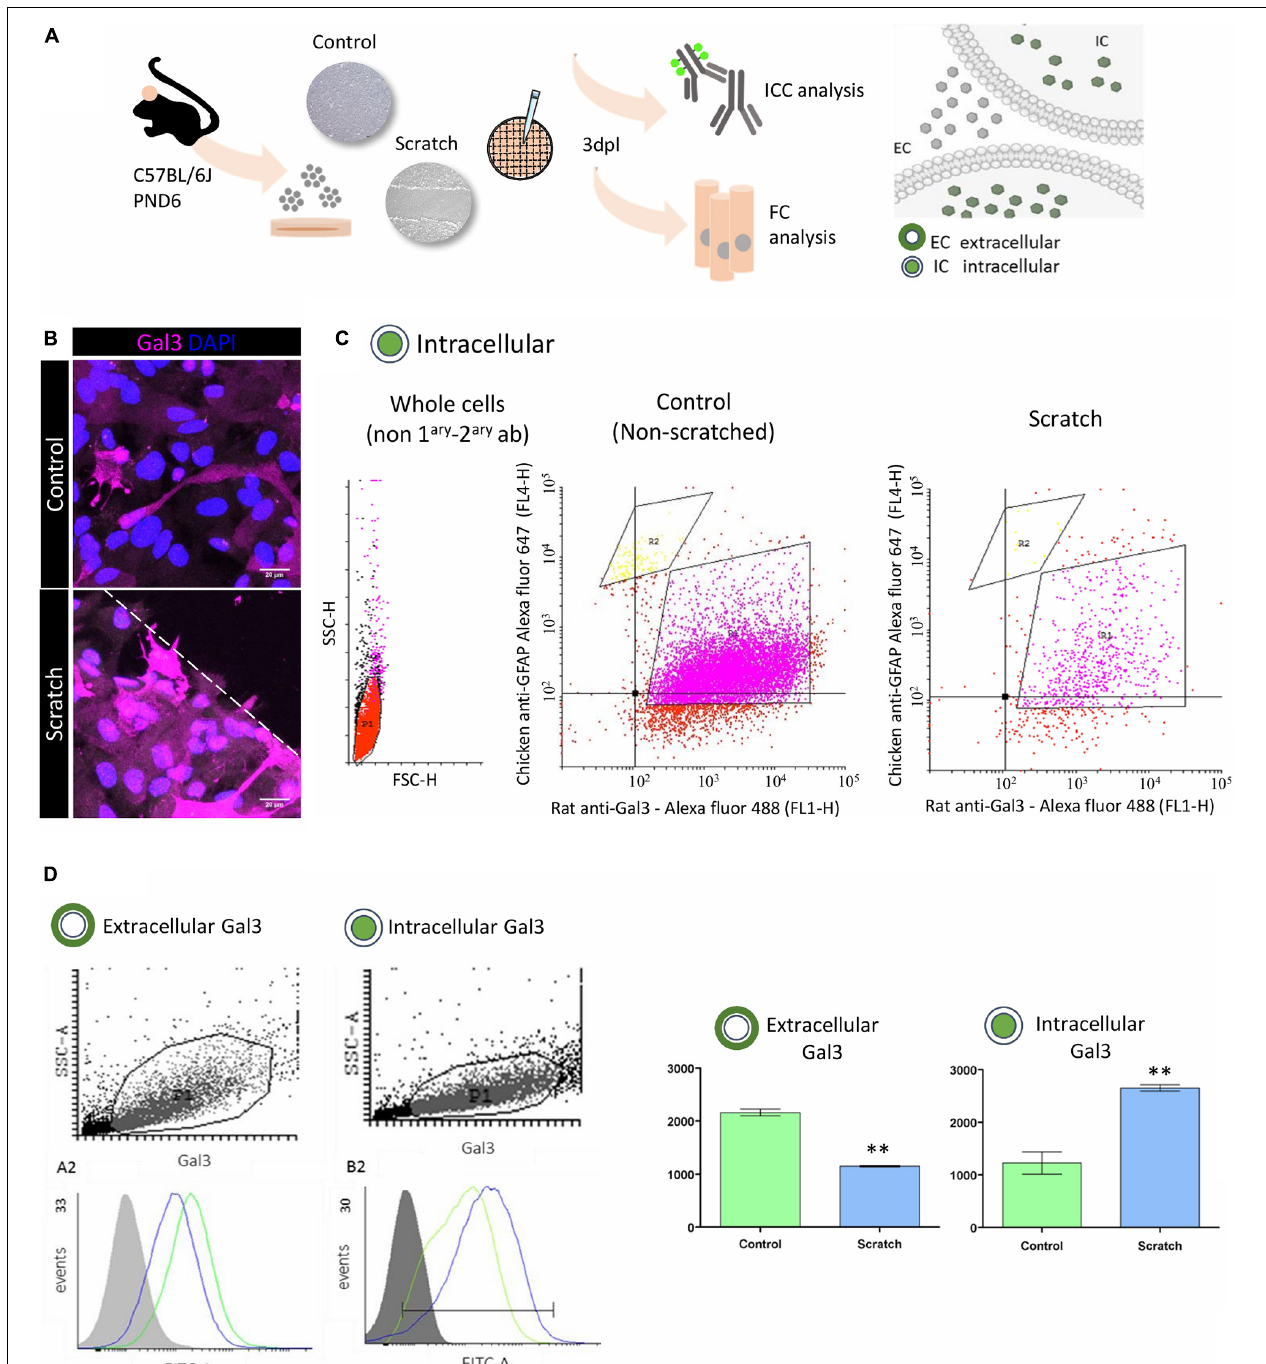
FIGURE 2 | In vitro astrocyte activation increases intracellular Gal3. (A) Experimental design: Gal3 localization in control (non-scratched) and reactive (scratched) astrocytes was analyzed by immunocytochemistry and flow cytometry. (B) Representative Z-stack confocal images of Gal3 immunolocalization in control and reactive astrocytes in vitro . Dashed line indicates scratch border. Scale bar: 20 µ m. (C) Flow cytometry cell distribution analysis of control and reactive astrocytes showed two subpopulations: R1, GFAP + /Gal3 + (75.70% of total number of cells) and R2, GFAP + /Gal3 − (3.25% of total number of cells). Data correspond to geometric mean. (D) Analysis of Gal3 distribution between the extracellular and intracellular compartments in control and reactive astrocytes showed that at 3dpl, control astrocytes presented more extracellular Gal3 compared to reactive astrocytes (** p ≤ 0.01, unpaired Student’s t -test, n = 3). Conversely, intracellular Gal3 was increased in reactive astrocytes compared to control (** p ≤ 0.01, unpaired Student’s t -test, n = 3). Data correspond to mean ± SD. A minimum of 10,000 events per sample per experiment were analyzed, and data was processed using Cyflogic TM software (CyFlo Ltd., Finland).